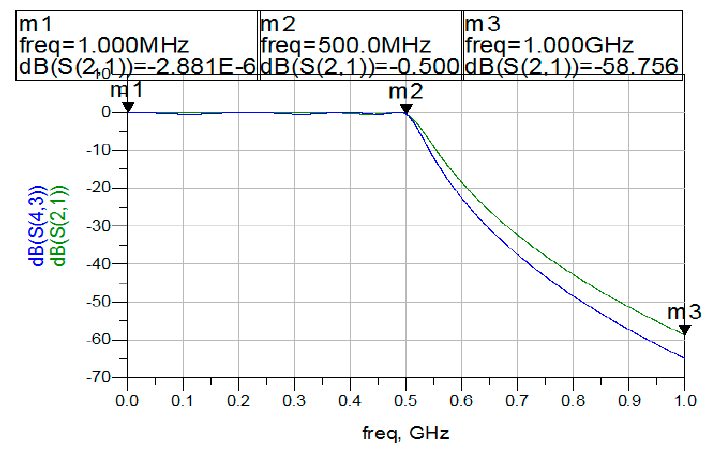
Figure 10. Simulation of low-pass filters in ADS 2011 (green: Pascal; blue: Chebyshev).